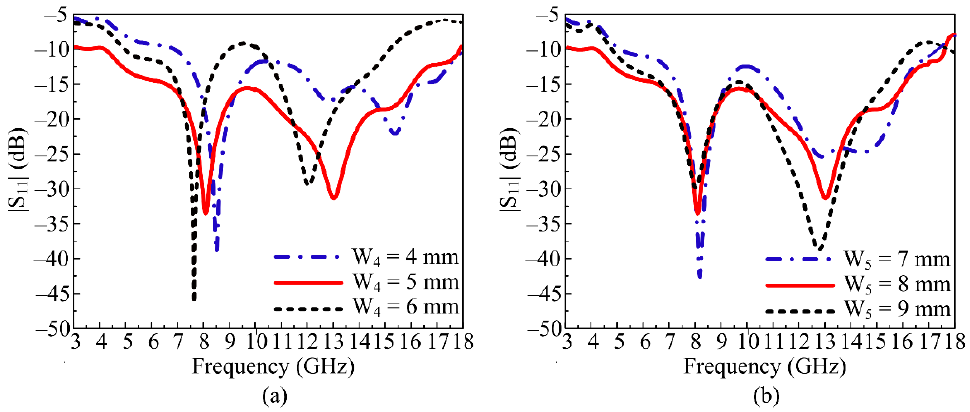
Figure 4. Parametric analysis of key parameters’ variation and its results: ( a ) length of the lower stub (W 4 ) ( b ) length of the upper stub (W 5 ).